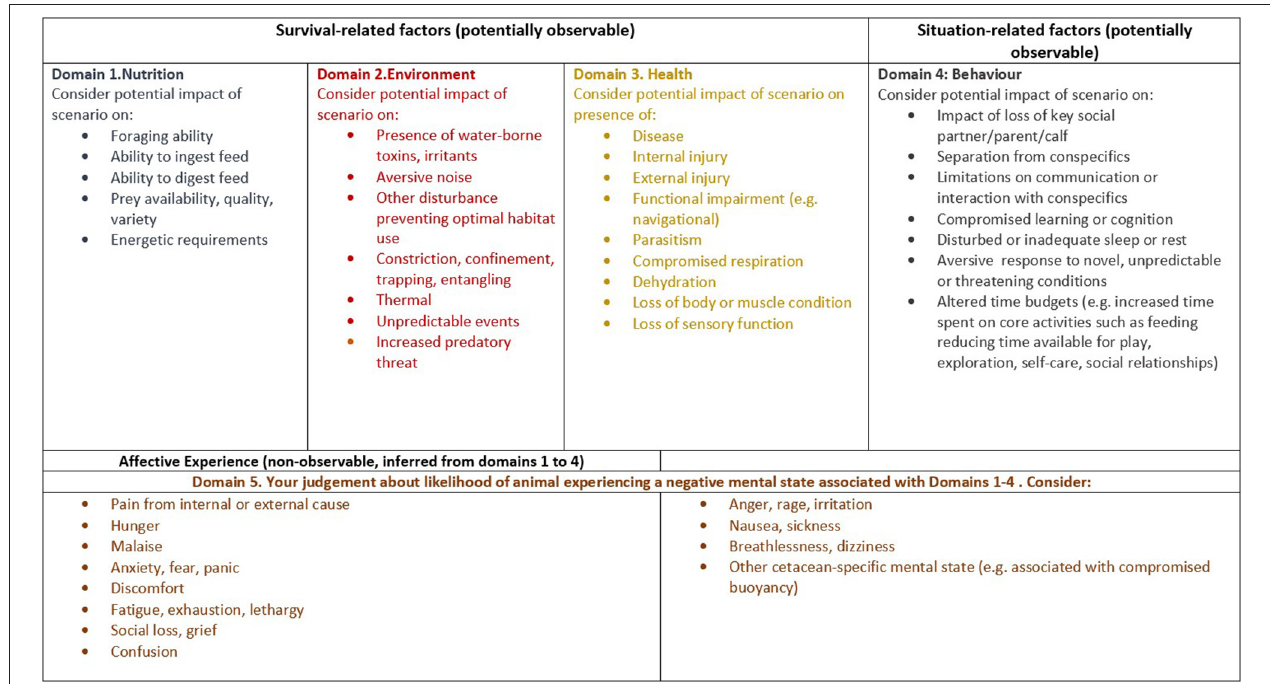
FIGURE 1 | An adapted version of the Five Domains Model (44) designed to guide the assessment of the harmful effects of human activities on the welfare of wild cetaceans. Within the framework, Domains 1–4 list factors affecting cetacean welfare that could, potentially, be observable and/or measurable. Domain 5 takes aspects from each of these domains and infers the mental states that the animal may experience as a result of external stresses and challenges. These words are, necessarily, a surmised interpretation of cetaceans’ mental states based on our own human emotional experiences. All negative domain states should be interpreted to mean negative states beyond an animal’s normal coping capacity. It is expected that a number of the factors listed are likely to be of considerably greater significance to some cetacean species, for example, the known complexity of, and reliance on, social groupings in certain